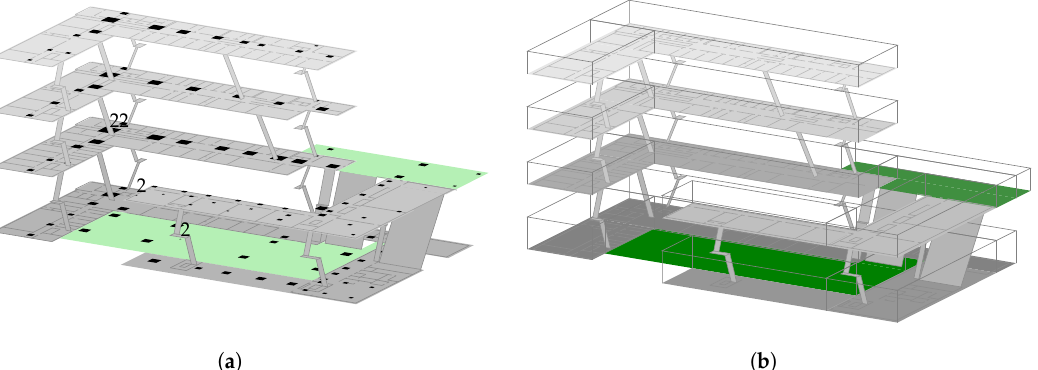
Figure 2. Locations of the 121 reference measurements (left) and bounding-boxes used for model per region (right). Indoor-areas are denoted using a grey fill-color per floor, outdoor-areas are green. ( a ) The size of each square denotes the number of permanently-installed APs that were visible while scanning and ranges between two and 22 with an average of nine; ( b ) each distinct floor-color denotes a region (six indoors, one outdoors) for model per region. Often more than one bounding box is needed to describe the region’s